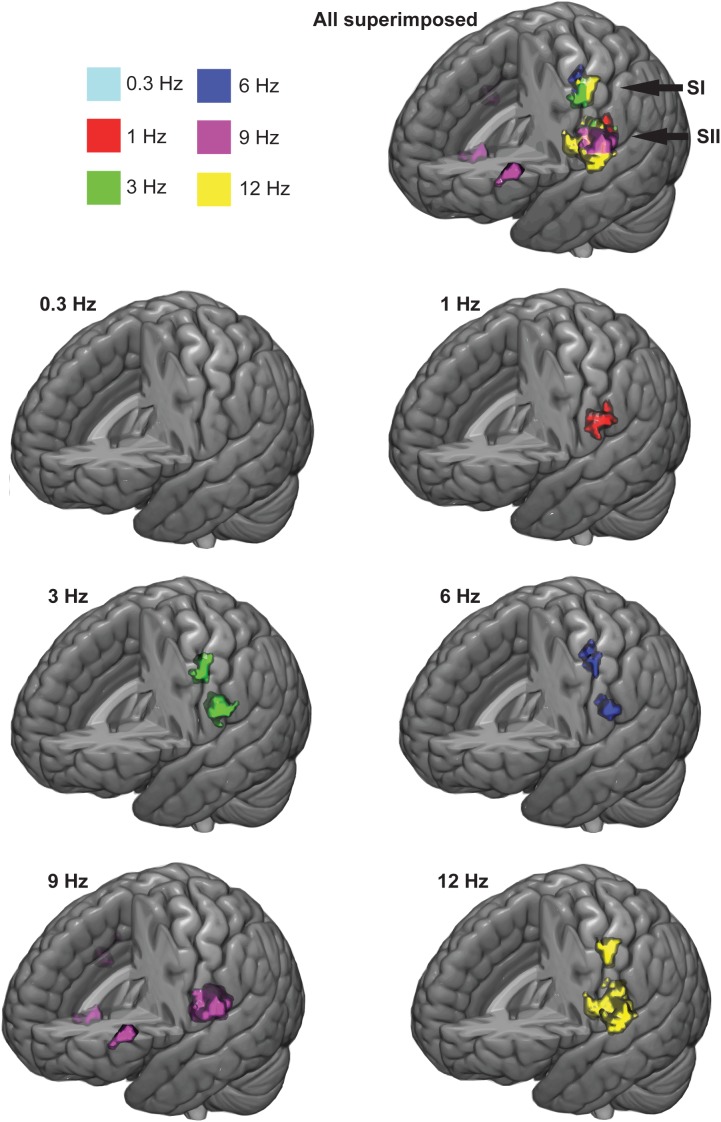
Group-averaged response clusters. The significant cortical clusters are colored for each movemet frequency separately. Cluster-wise threshold was 0.05 (FDR-corrected) and voxel-wise threshold was 0.001 (uncorrected).